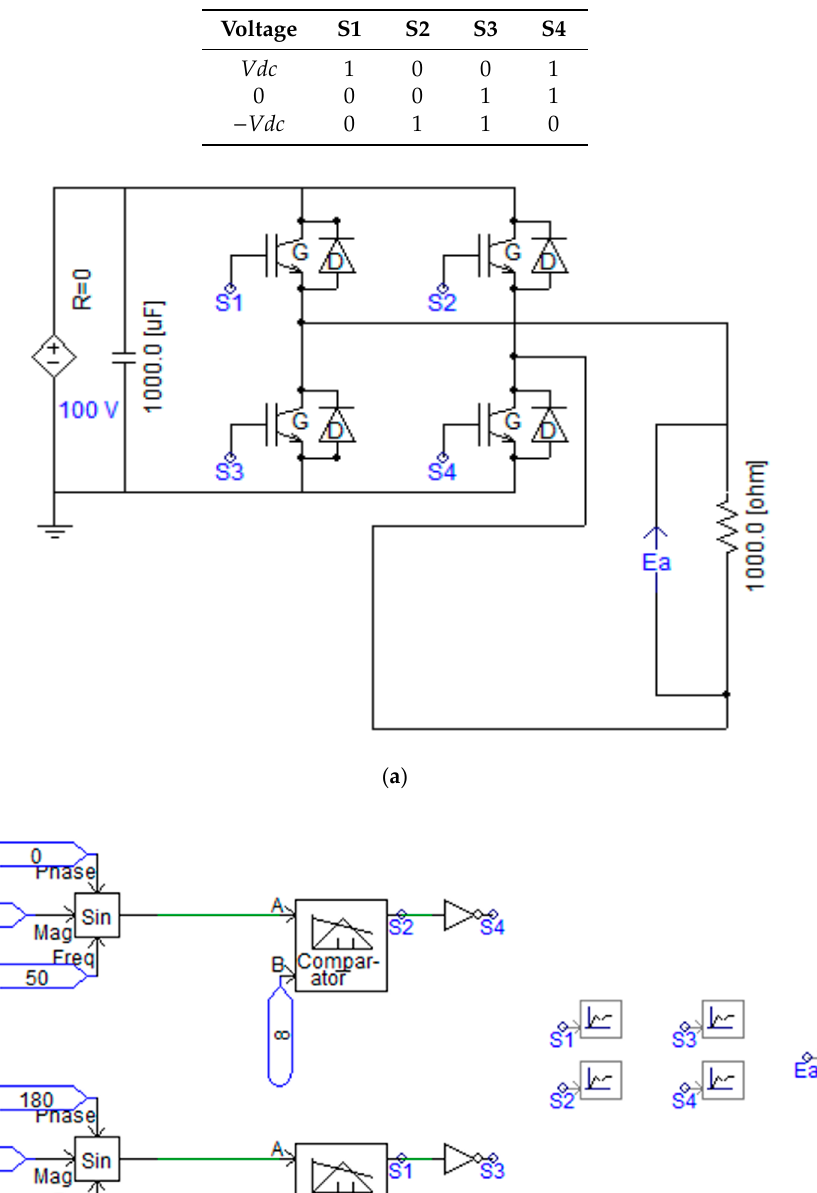
Table 3. Voltage levels of 3-level cascade H-bridge multilevel inverter and switching states.